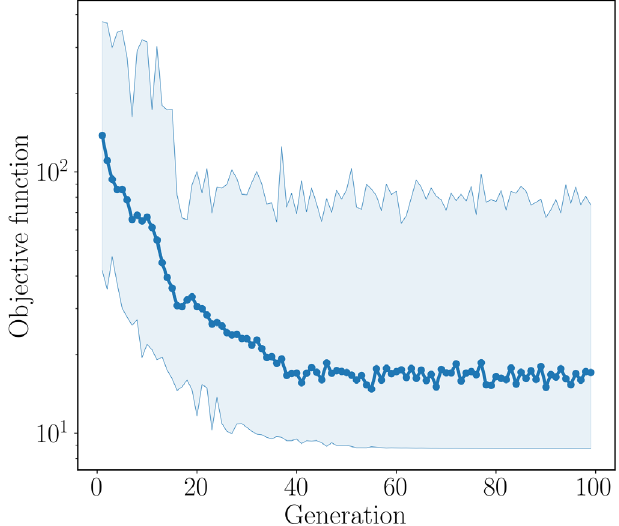
FIG. 2. Mean (data points) and range (shaded region) of the objective function evaluations from a population of solutions used by a genetic algorithm for the optimization of quadrupole strengths and positions.